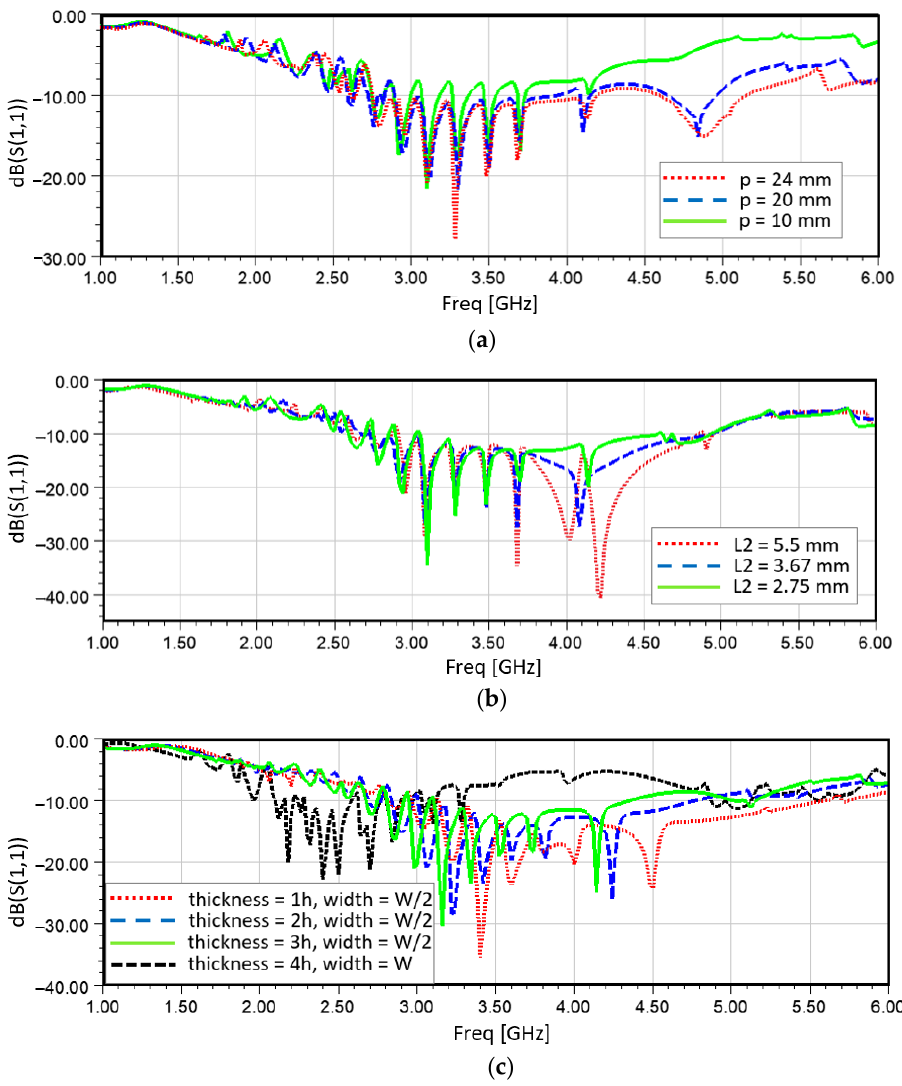
Figure 8. Reflection coefficients of the proposed antenna 1 for different values of ( a ) the tapered slot opening, ( b ) the feed transition length, and ( c ) the width and thickness of the superstrate.